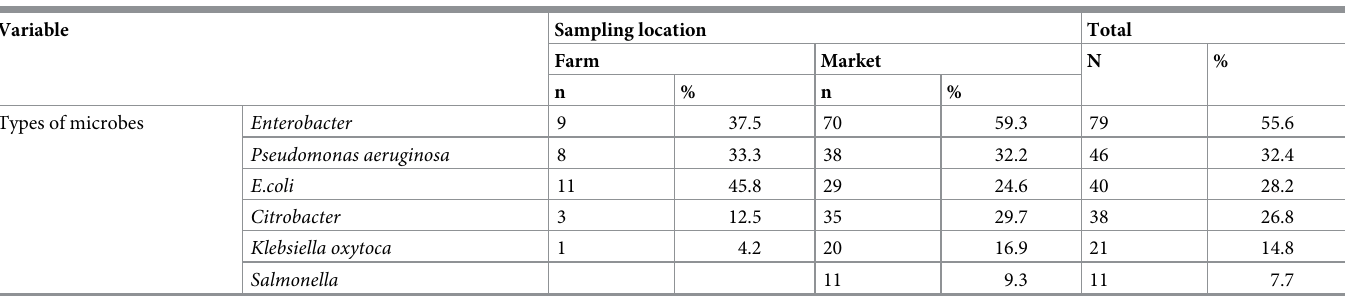
Table 7. Types of pathogenic bacteria isolated from fresh vegetables.